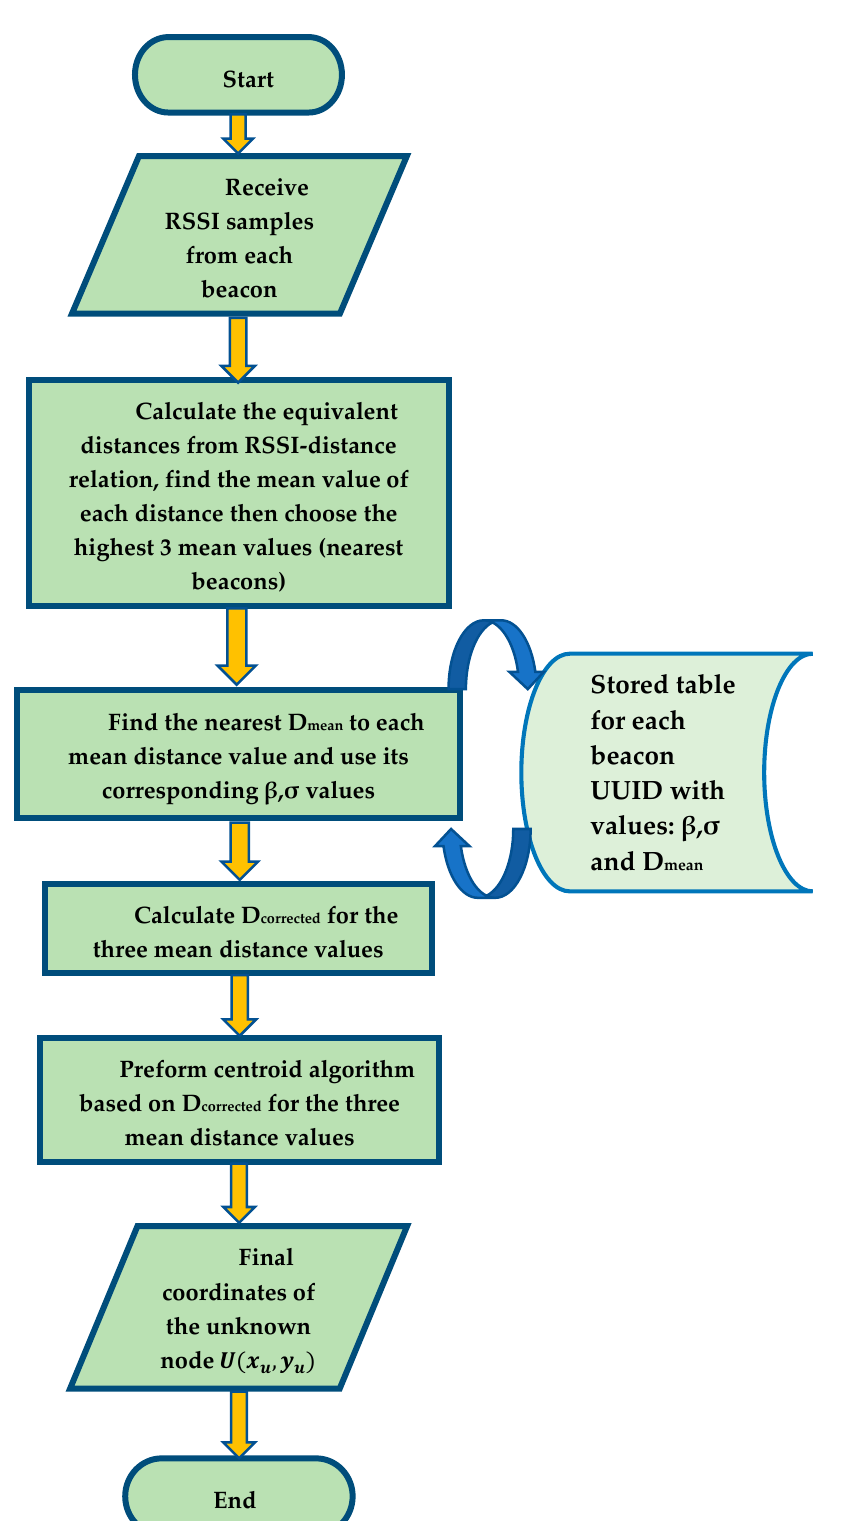
Figure 5. A Flow chart of the proposed enhanced centroid positioning algorithm.